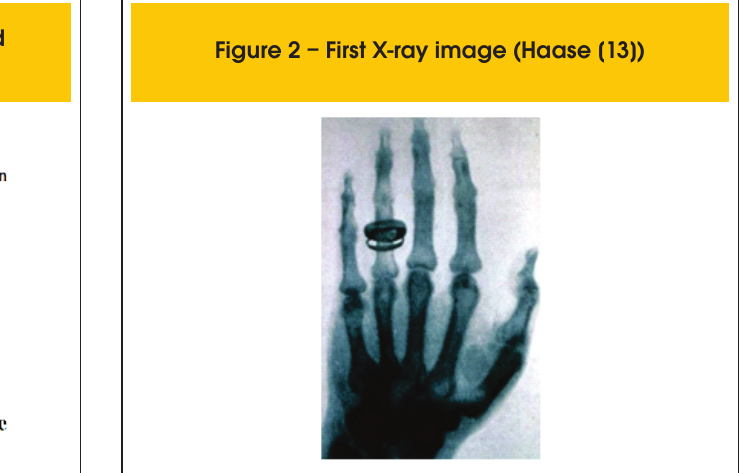
Figure 1 – Conventional ultrasonic method for internal flaws searching